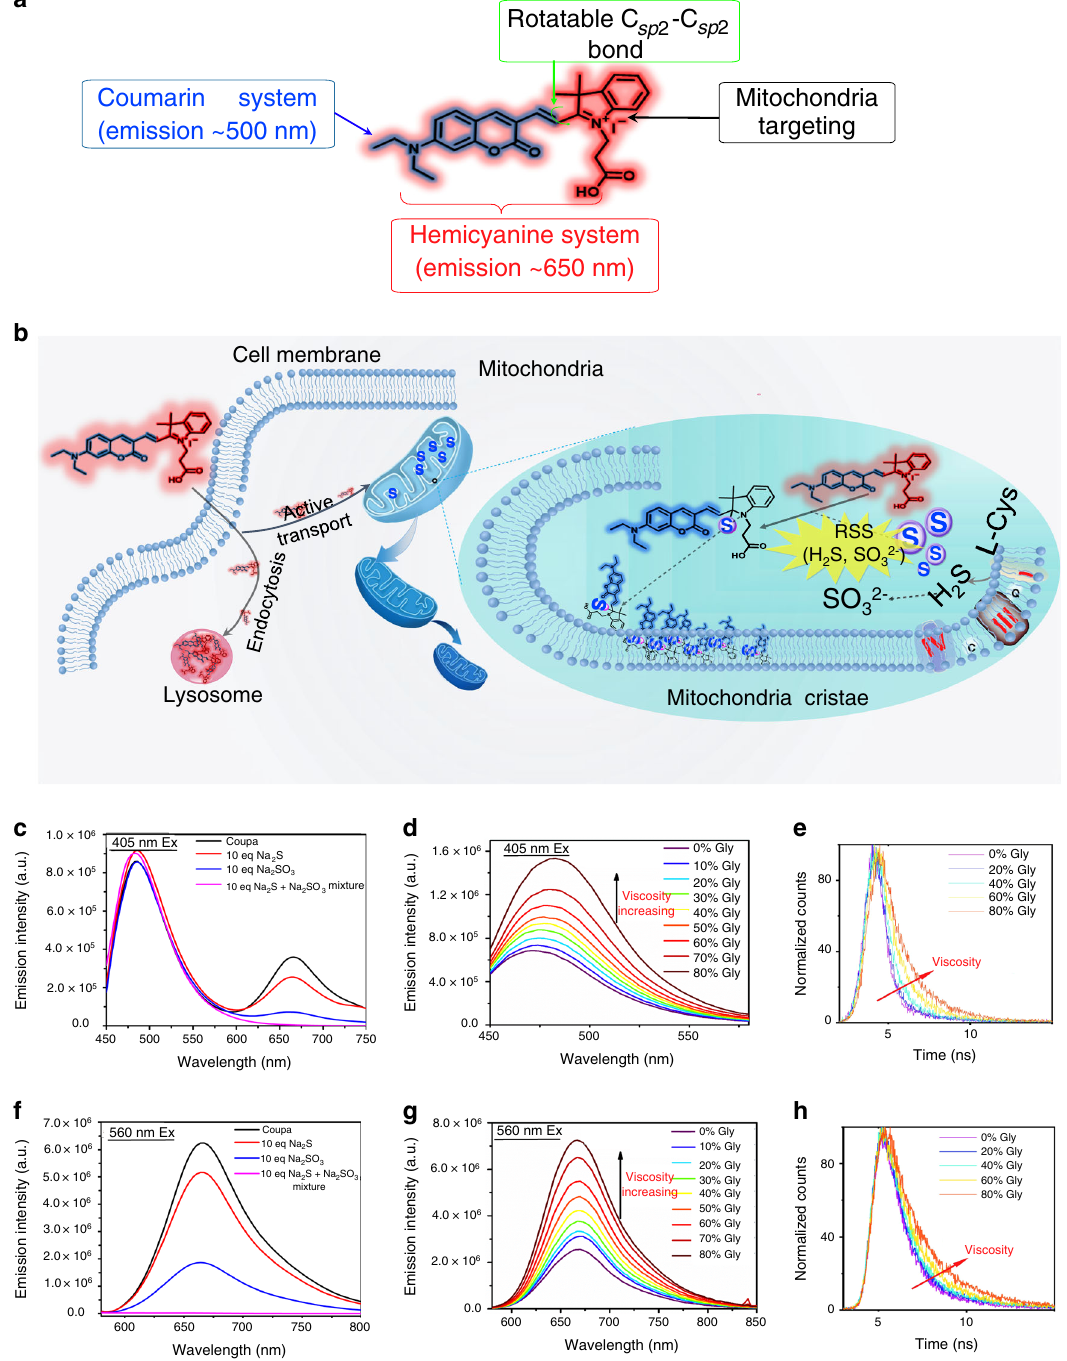
Fig. 1 Design and fl uorescence characterization of Coupa. a Chemical structure of Coupa and the role of each functional moieties. The structure possesses two ICT emission peaks — coumarin, which peaks at approximately 500 nm, and a hemicyanine system, which peaks at approximately 650 nm — that can target mitochondria via its positive charge and respond to viscosity via altering its C sp 2 – C sp 2 rotation. b Proposed mitochondria- and lysosome- staining mechanisms of Coupa. Coupa stains mitochondria by direct absorption, whereas lysosomal staining could result from active transport and endocytosis. Fluorescence spectra of Coupa were determined upon excitation at 405 nm ( c and d ) and 560 nm ( f and g ). c , f Fluorescence spectra determined with Na 2 S and Na 2 SO 3 treatments, and Na 2 S and Na 2 SO 3 completely quenched the red fl uorescence (660 nm emission), leading to different Coupa emission with and without RSS. d , g Fluorescence spectra determined in media (glycerol/ methanol mixed solvent) with different viscosity; and e , h fl uorescence decay pro fi les of Coupa in glycerol/methanol mixtures determined with picosecond pulsed excitation at 340 nm ( e , Em at 535 nm) and 535 nm ( h , Em at 670